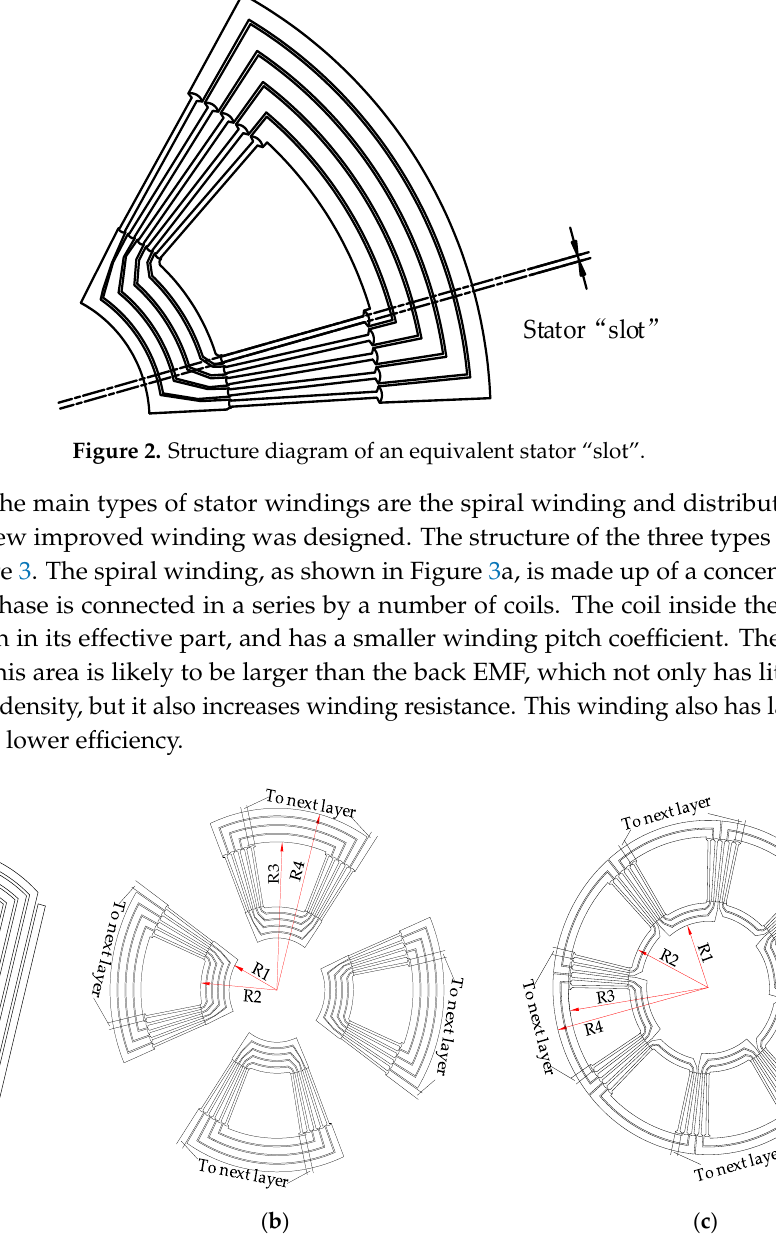
Figure 2. Structure diagram of an equivalent stator “slot” .